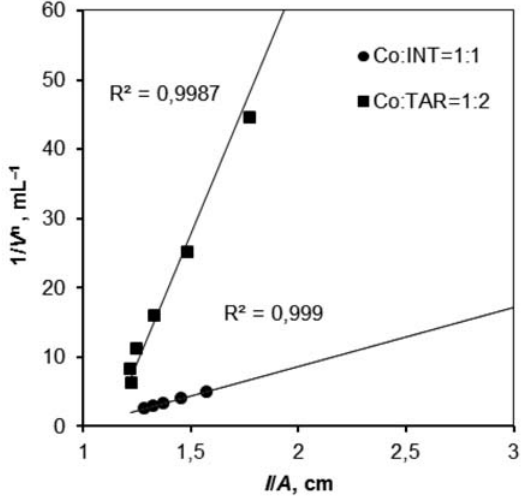
Figure 4. Determination of the molar ratio (n) by the method of Asmus: C = 1.7 × 10 –5 mol L –1 ; • Co(II) : INT C Co(II) 10 –4 mol L –1 n = 1; (cid:2) Co(II) : TAR C